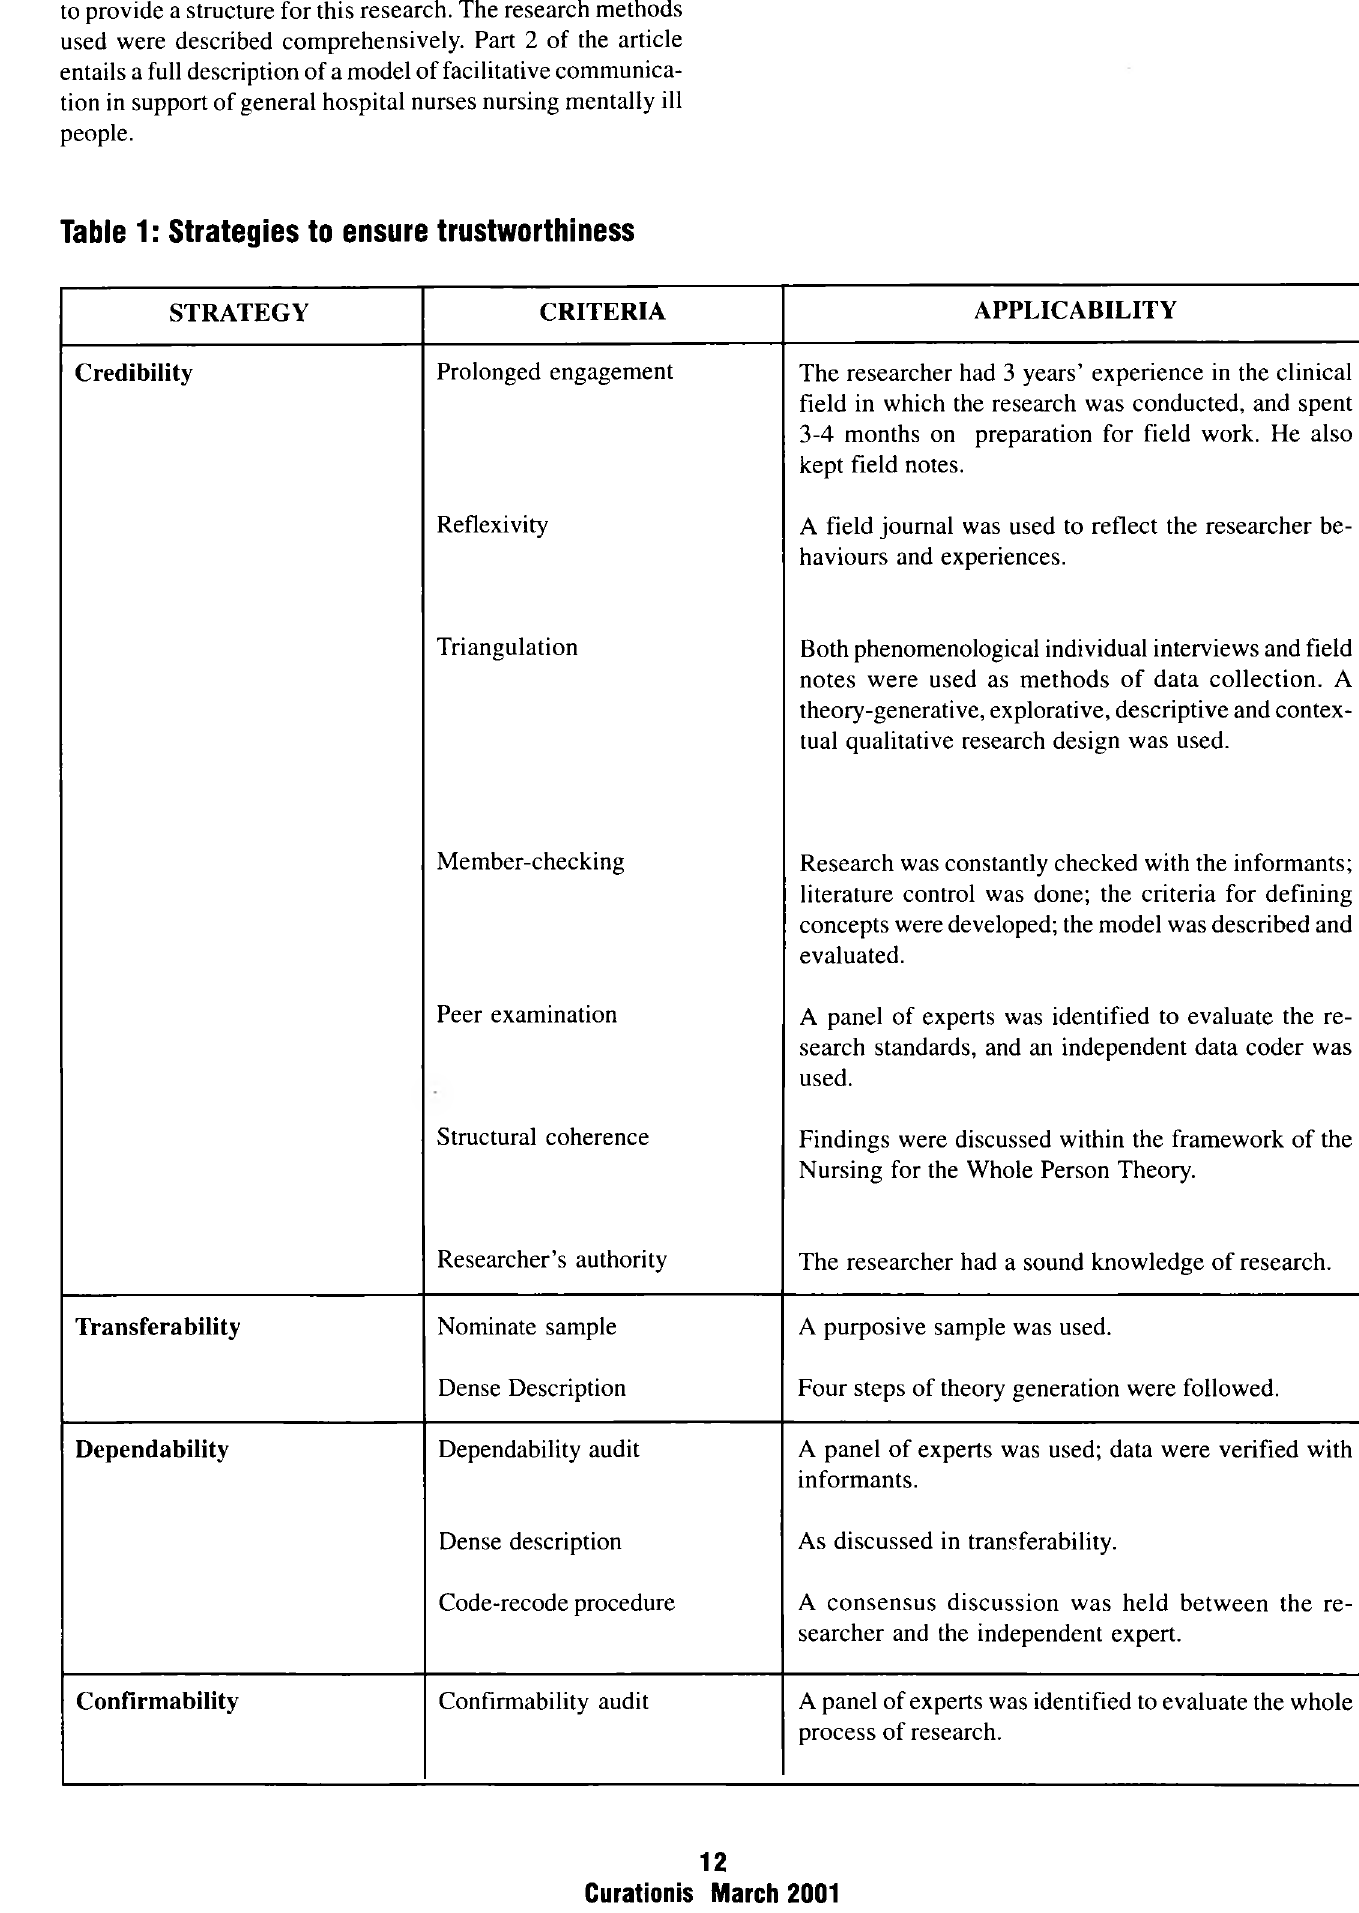
Table 1 : Strategies to ensure trustworthiness STRATEGY